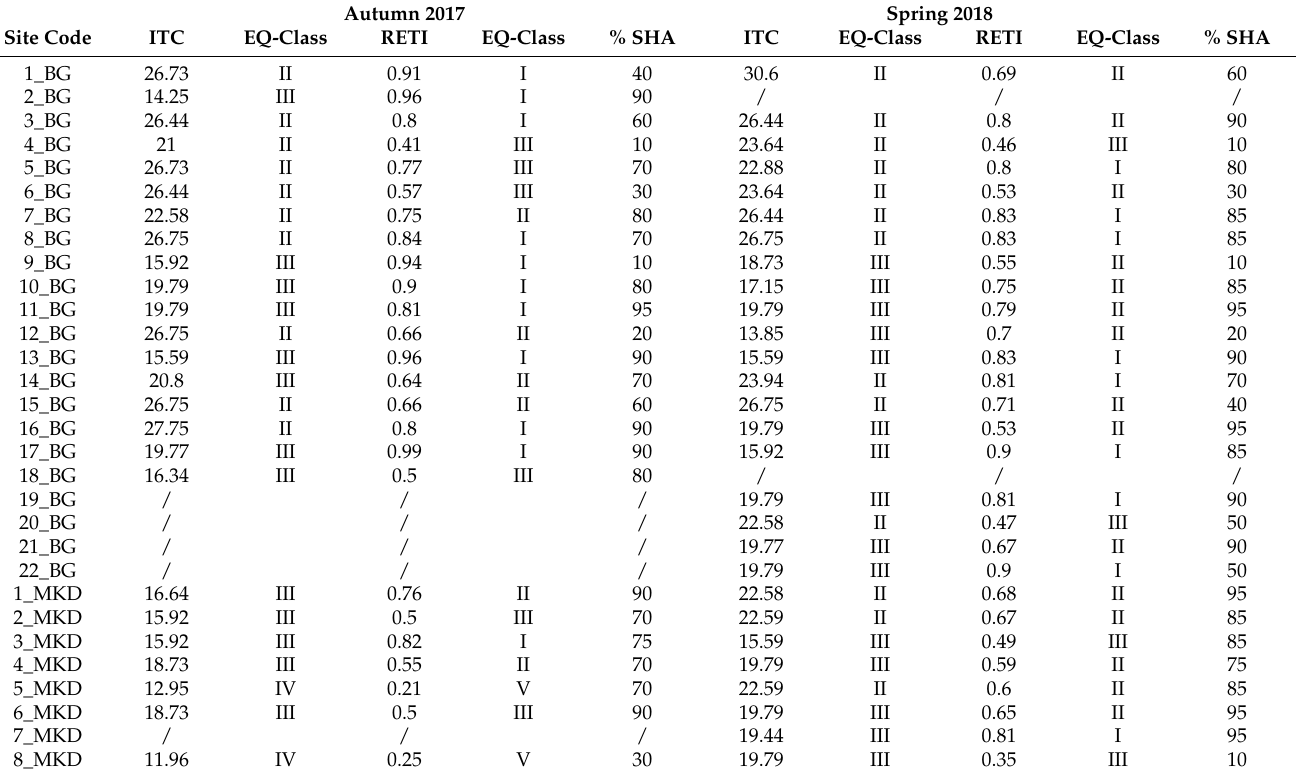
Table A1. Values of ITC and RETI indices, the corresponding ecological quality class (EQ-class) and the degree of shading (% SHA) per studied sites and sampled